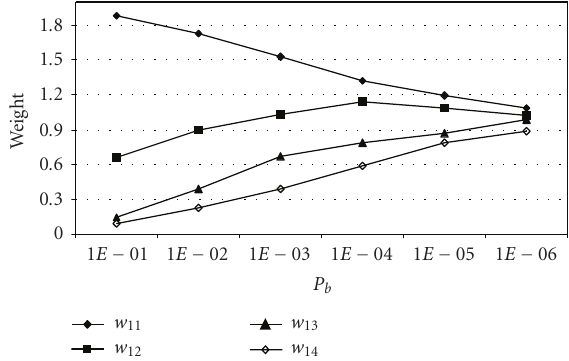
Figure 10: Weights values at varying channel conditions for the pa- rameter u 1 ( τ ).